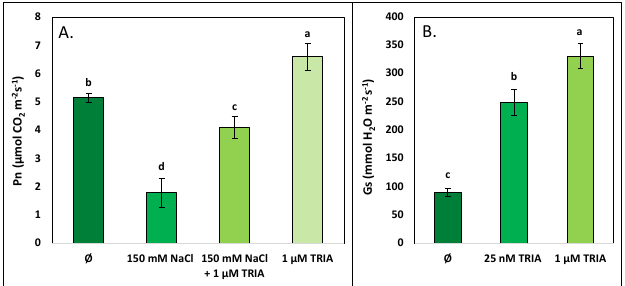
Fig. 4: Net CO 2 assimilation rate (Pn) and stomatal conductivity (Gs) in leaves of spinach plants exposed to high salinity, with or without triacontanol (TRIA) treatment. Ø stands for the control group. Vertical bars represent ± standard error from means (n=5), different letters above the columns indicate significant differences at P < 0.05 (Tukey’s HSD test)